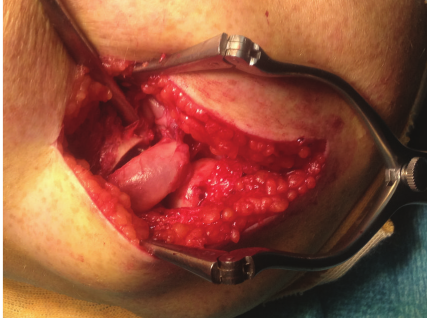
Figure 3: Radial neck palmar subtraction osteotomy of 60 ∘ on a pronated